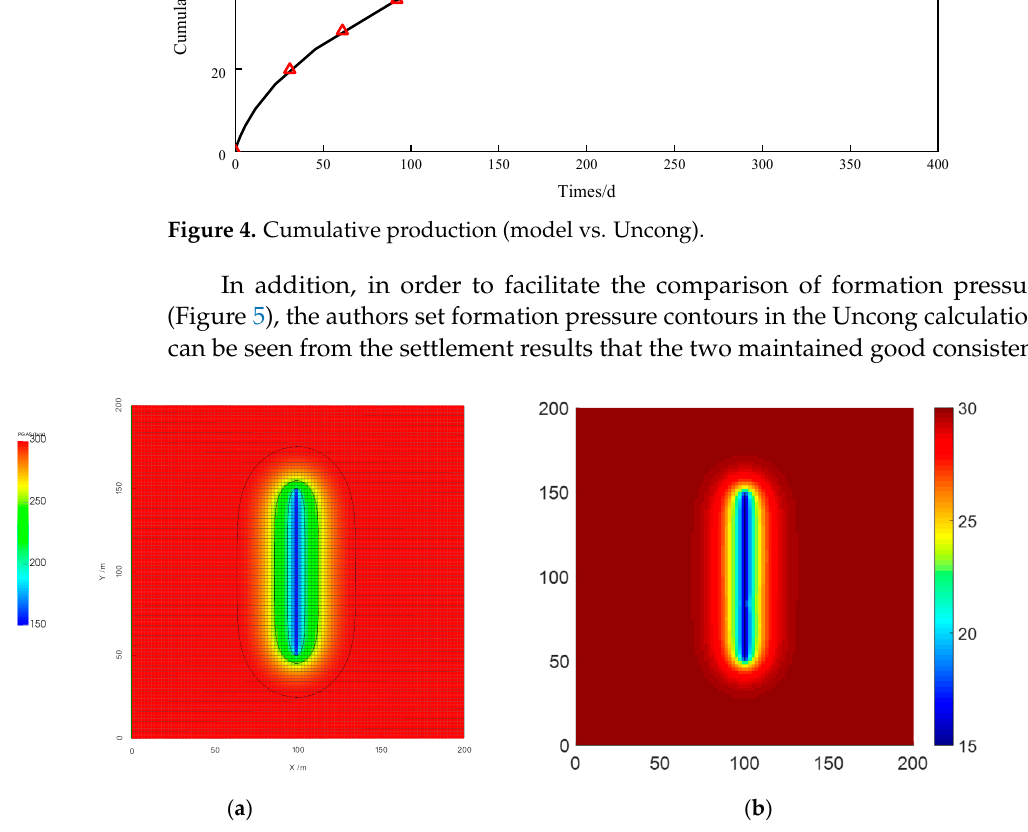
Figure 5. Formation pressure (model vs. Uncong). ( a ) Result from Uncong. ( b ) Result from model.